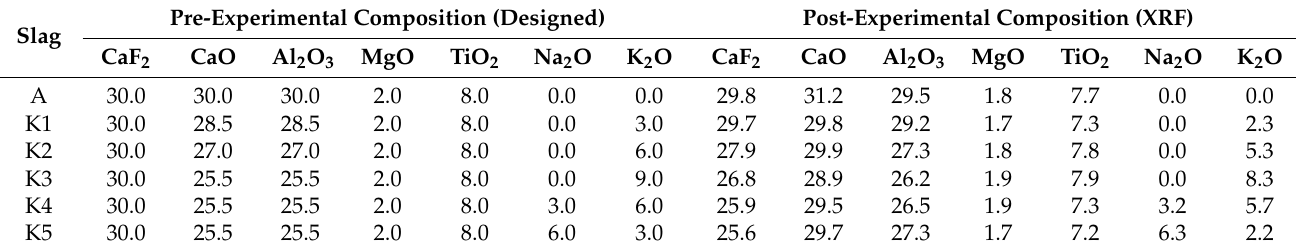
Table 1. Chemical compositions of the slag samples